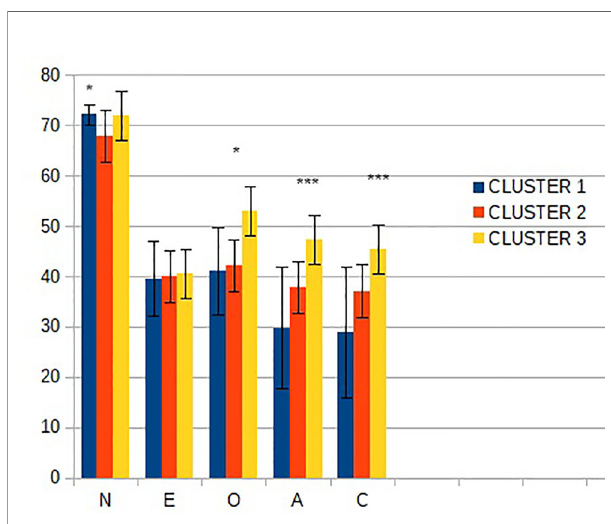
FIGURE 2 | Personality traits scores (mean ± SD) in the three subgroups de fi ned by Latent Class Cluster Analysis. N, neuroticism; E, extraversion; O, openness; A, agreeableness; C, conscientiousness; * p < 0.05; *** p <